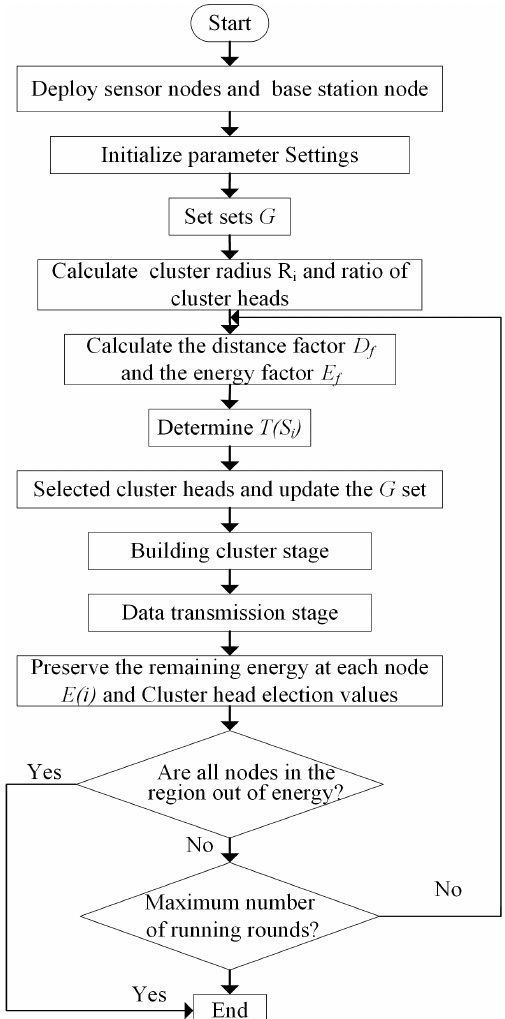
Figure 4. Flow chart of the SERP protocol